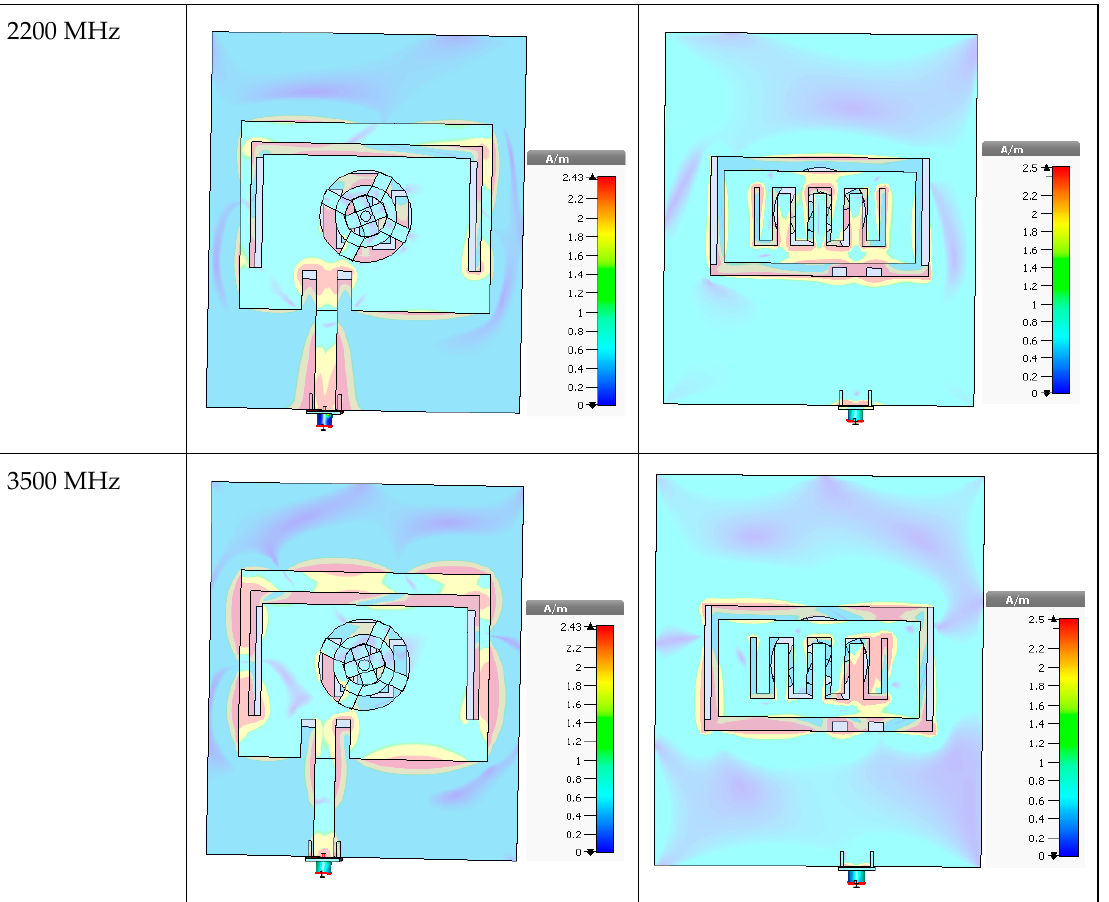
Figure 9. Surface current distribution for the antenna obtained in the three-frequency bands optimization case.